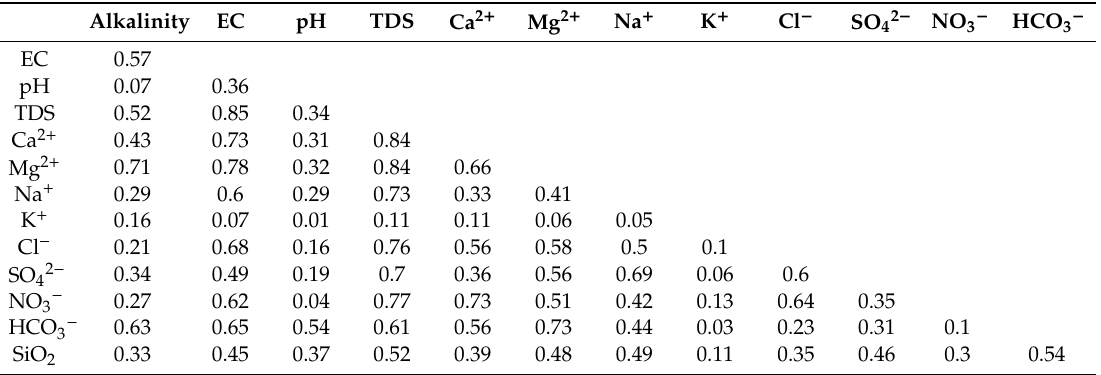
Table 2. Pearson correlation matrix.